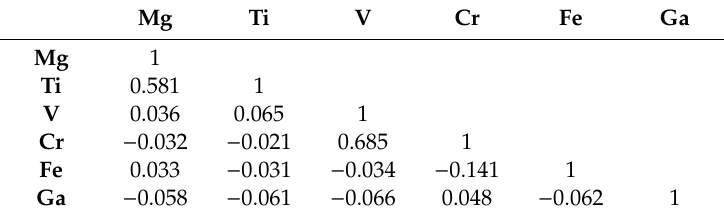
Table 5. Correlation table for trace elements of blue sapphires from Mogok, Myanmar.